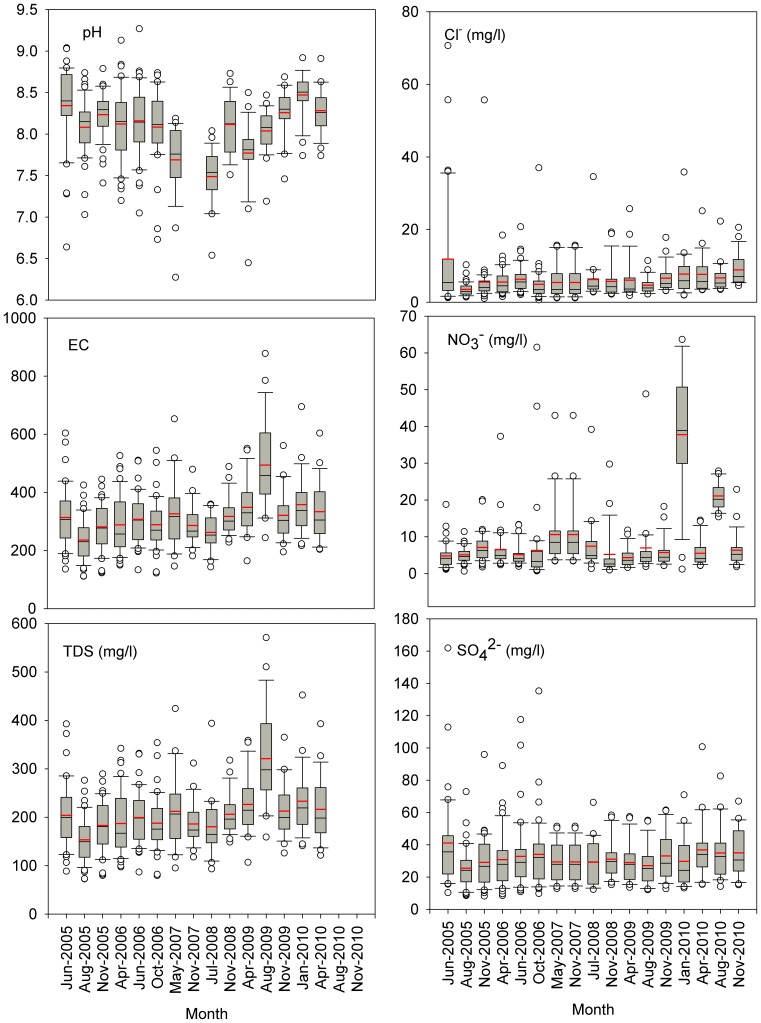
Changes of water chemistry during 2005–2010 in the upper Han River, China (red line represents mean values).